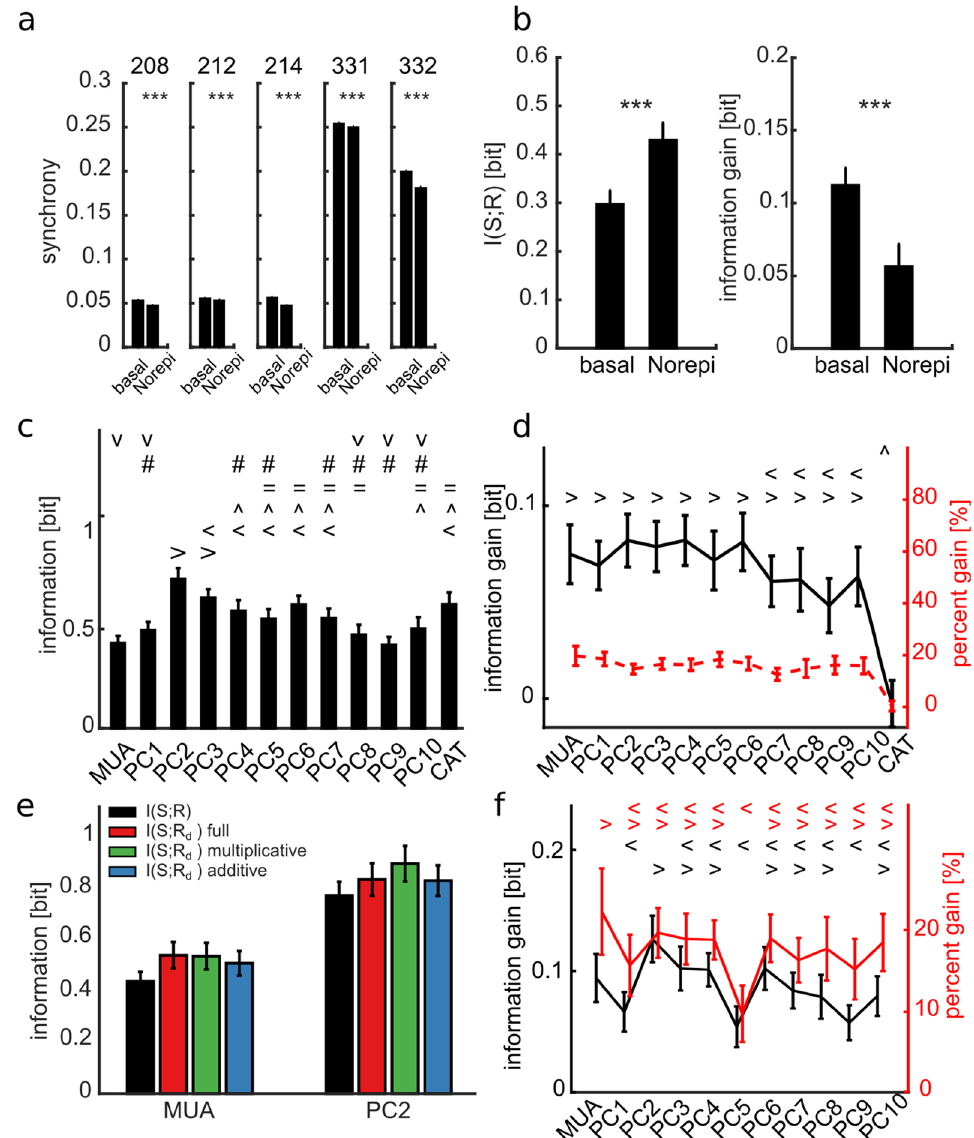
Figure 6. Cell cultures treated with norepinephrine display increased information and decreased information gain with respect to the basal untreated condition. ( a ) Each box-plot shows mean ± SEM of the spike synchronization coefficient computed over 100 randomly selected sets of 100 electrodes from the whole array. The synchronization coefficient decreases significantly when the norepinephrine drug is added in all tested cell cultures (two tailed t test, p = 10 − 6 , p = 10 − 4 , p = 10 − 6 , p = 10 − 4 , p = 10 − 6 for, respectively, session 208, 212, 214, 331 and 332, black stars). ( b ) Mean ± SEM across experiments and time window [0 100] ms of information and information gain computed with MUA as response feature and TB as state variable for basal and norepinephrine conditions. Black stars label significant difference between basal and norepinephrine conditions (one tailed t test, p = 10 − 10 and p = 10 − 9 for information and information gain). ( c ) Mean ± SEM across experiments with norepinephrine of the information with different response features (MUA, PC, CAT) computed over the [0 100] ms time window after stimulus. Different symbols indicate no significantly different means (F(12, 1287) = 34.4, p = 10 − 30 , one-way between subject ANOVA followed by HSD multiple comparison test). ( d ) Mean ± SEM across experiments with norepinephrine of information gain and percentage information gain. Different symbols indicate no significantly different means of different response features (F(12, 1287) = 7.1, p = 10 − 12 ). Note that no significant difference was found for percentage information gain (p = 0.6). ( e ) Mean ± SEM across all experiments for MUA and PC2 as different response features of the direct information in a time window of [0 100] ms after stimulus computed before (black bars) and after discounting state variable TB from the single trial response r , respectively for, the full model (red bars), the multiplicative model (green bars) and the additive model (blue bars). ( f ) Mean ± SEM across experiments with norepinephrine of information gain and percentage information gain of the multiplicative model. Different black and red symbols indicate no significantly different means of information gain (F(10, 1089) = 4.3, p = 10 − 6 ) and percent information gain (F(10, 1089) = 2.7, p = 0.002) for different response features. In panels c,d and f the symbols { > < ^ = # V} mark data groups that have similar means (Tukey’s HSD, p <